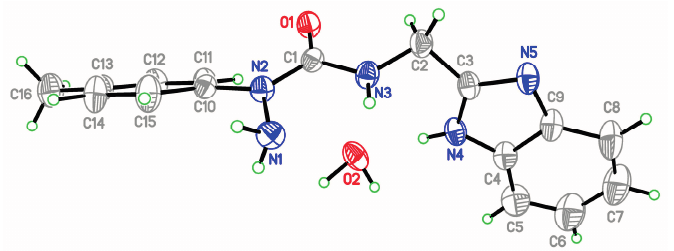
Figure 2. ORTEP drawing of 2-(4-methylphenyl)-4-[(1 H -benzo[ d ]imidazol-2-yl)methyl]- semicarbazide ( 8b